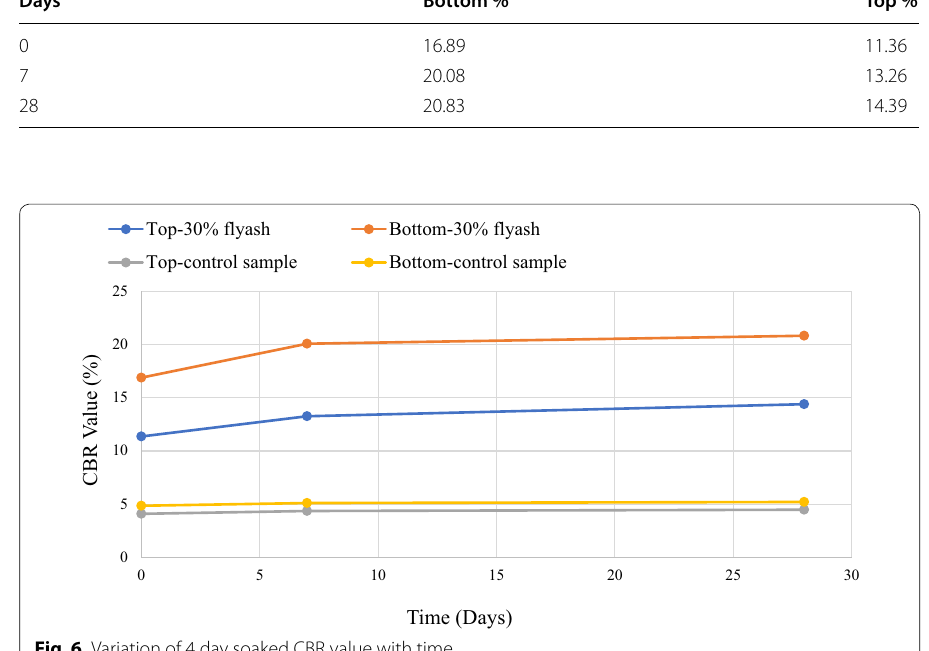
Fig. 6 Variation of 4 day soaked CBR value with